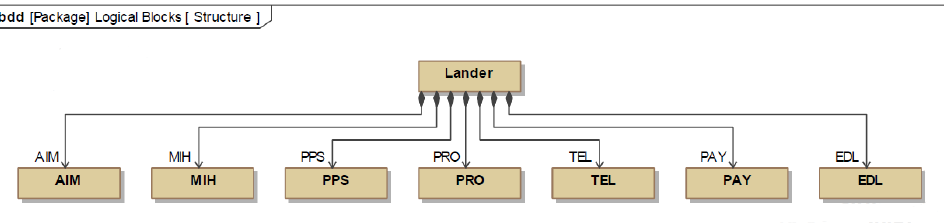
Figure 4. Lander Block Definition